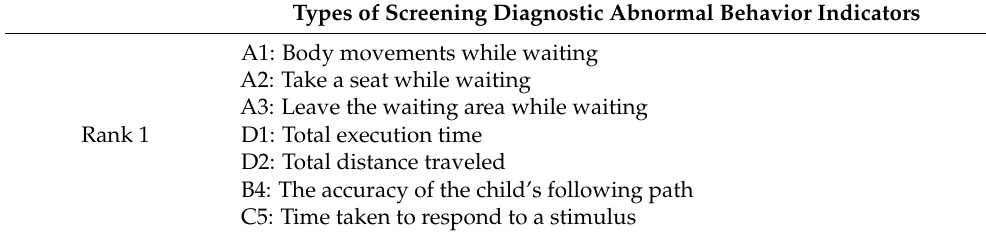
Table 3. Rank 1 extraction according to feature importance.